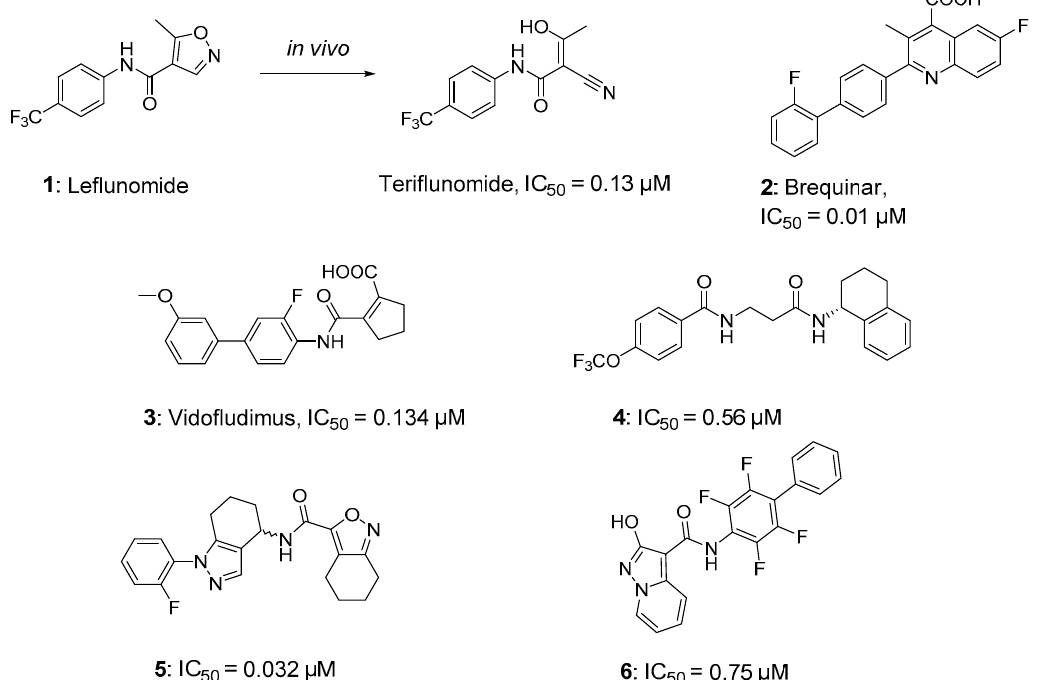
Figure 1. Structures of representative inhibitors of h DHODH.